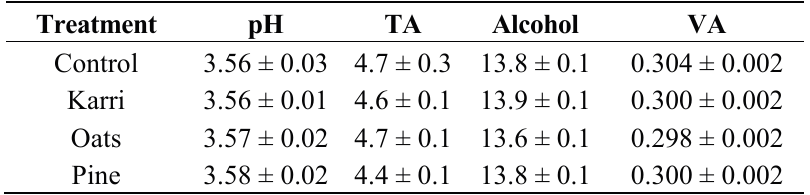
Table 1. Standard wine chemistry measures. Data are mean ±1 standard error ( n = 5). Total Acidity (TA) is grams per litre equivalent of 2,3-dihydroxybutanedioic acid (tartaric acid) and Volatile Acidity (VA) is grams per litre equivalent of acetic acid. Alcohol is weight per volume percentage of ethanol. Malic acid and residual sugars (sum of glucose and fructose) were below quantification limits (0.18 g/L and 0.1 g/L respectively).